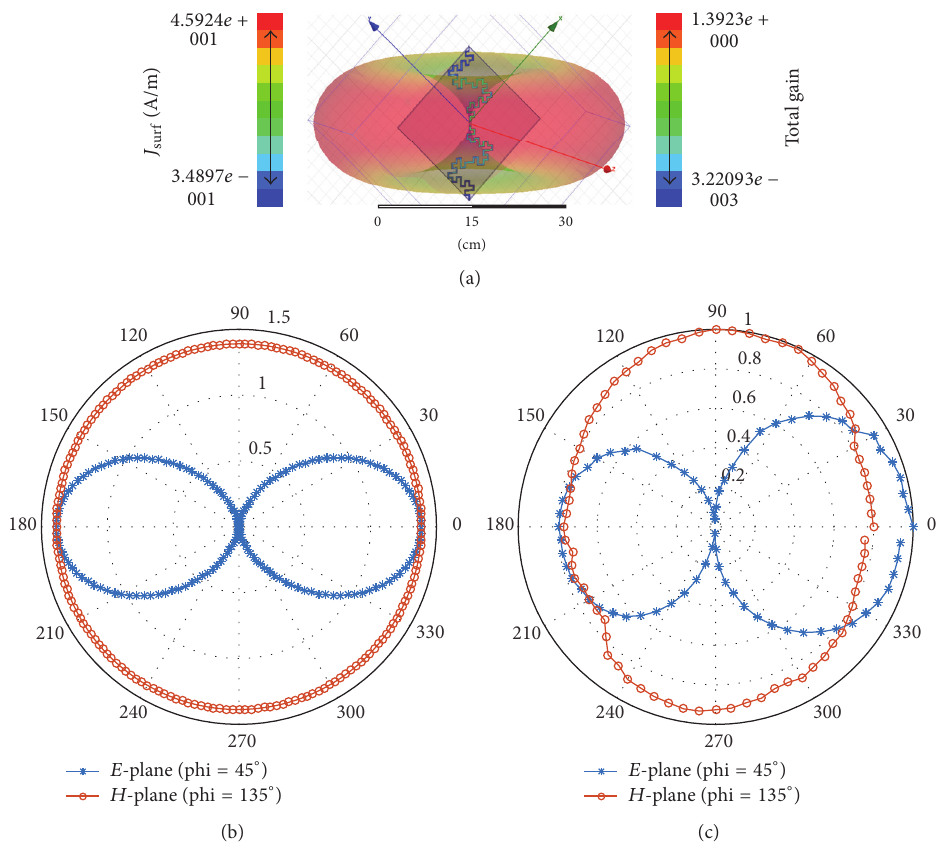
Figure 5: Radiation patterns at 436.5 MHz: (a) 3D simulated total gain pattern with respect to the PCB geometry and its corresponding magnitude of the current distribution on the antenna surface, (b) 2D plots for simulated normalized total gain patterns for the main antenna planes, and (c) 2D plots for measured normalized power patterns for the main antenna planes inside an anechoic chamber.